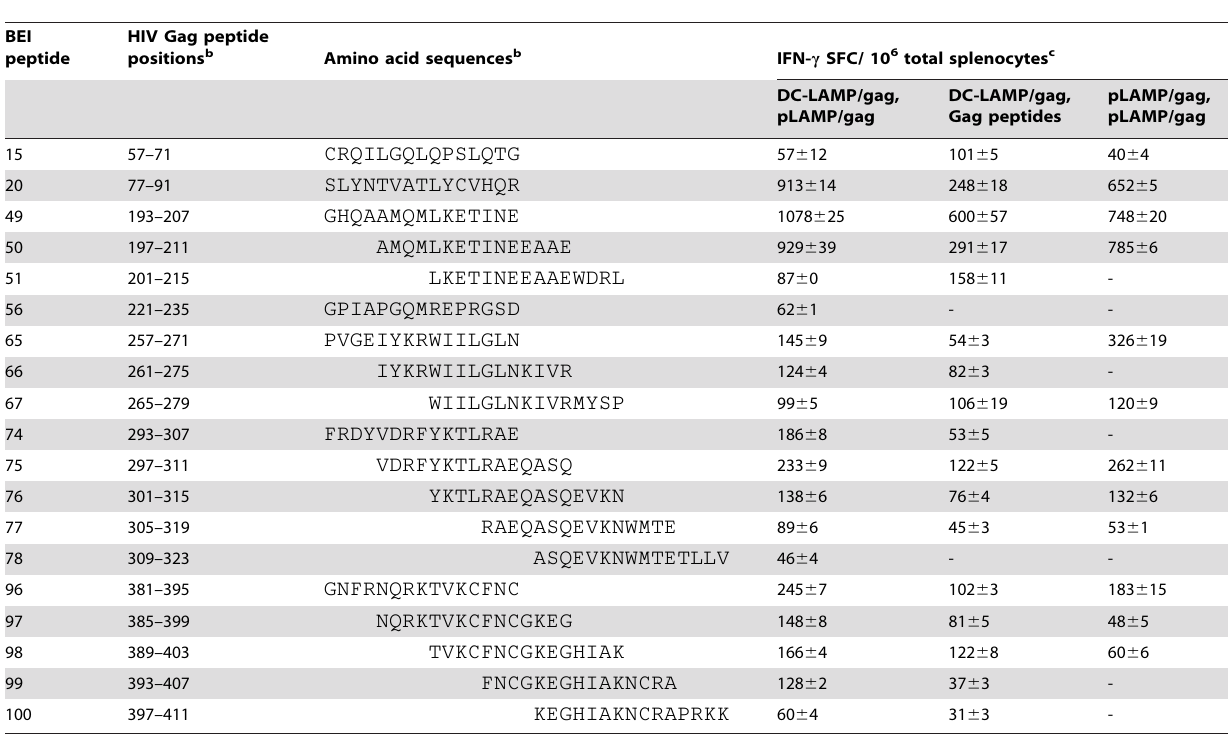
Table 1. HIV-1 Gag epitope peptides eliciting IFN- c -secreting T-cell responses in BALB/c (H-2d) mice immunized with pLAMP/gag- based prime and boost formulations a .